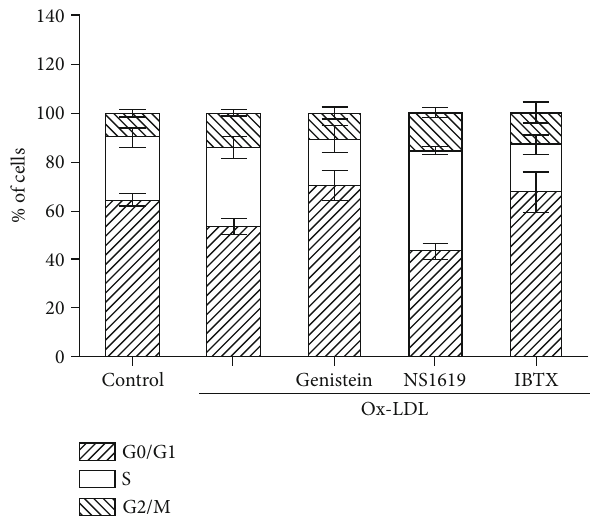
Figure 3: The e ff ect of genistein and BKCa channels on Ox-LDL- induced VSMC cell cycle. Cells were pretreated with genistein, NS1619, or IBTX for 6h before coincubated with Ox-LDL for another 72 h. The control group is cells without any treatment. The distribution percentages of cells in each phase were presented as the mean ± SD ( n = 3 per